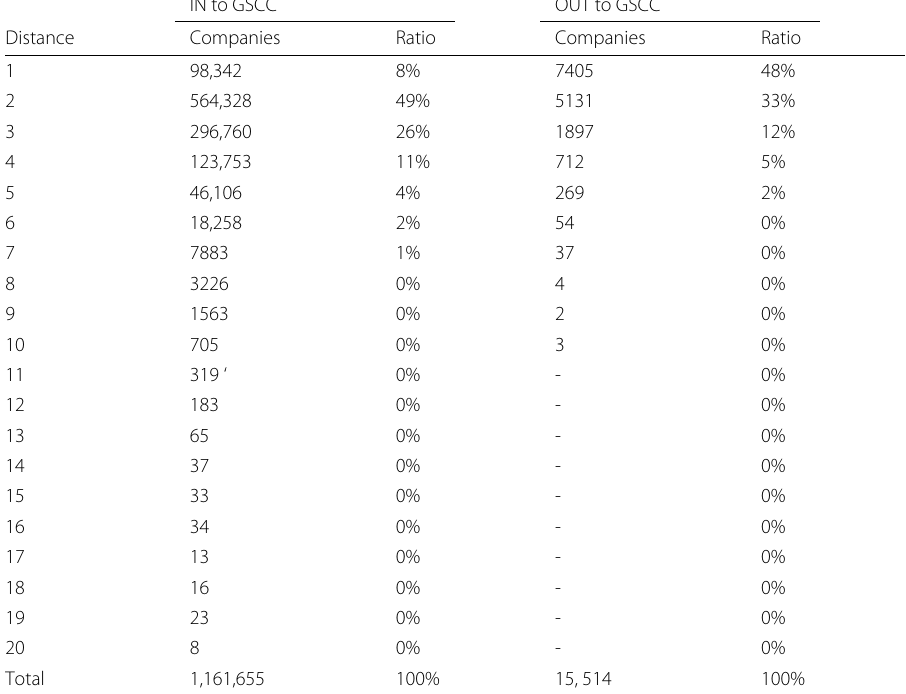
Table 2 The distribution of the shortest distance from nodes in the IN component to those in the GSCC and from nodes in the GSCC to those in the OUT component IN to GSCC OUT to GSCC Distance Companies